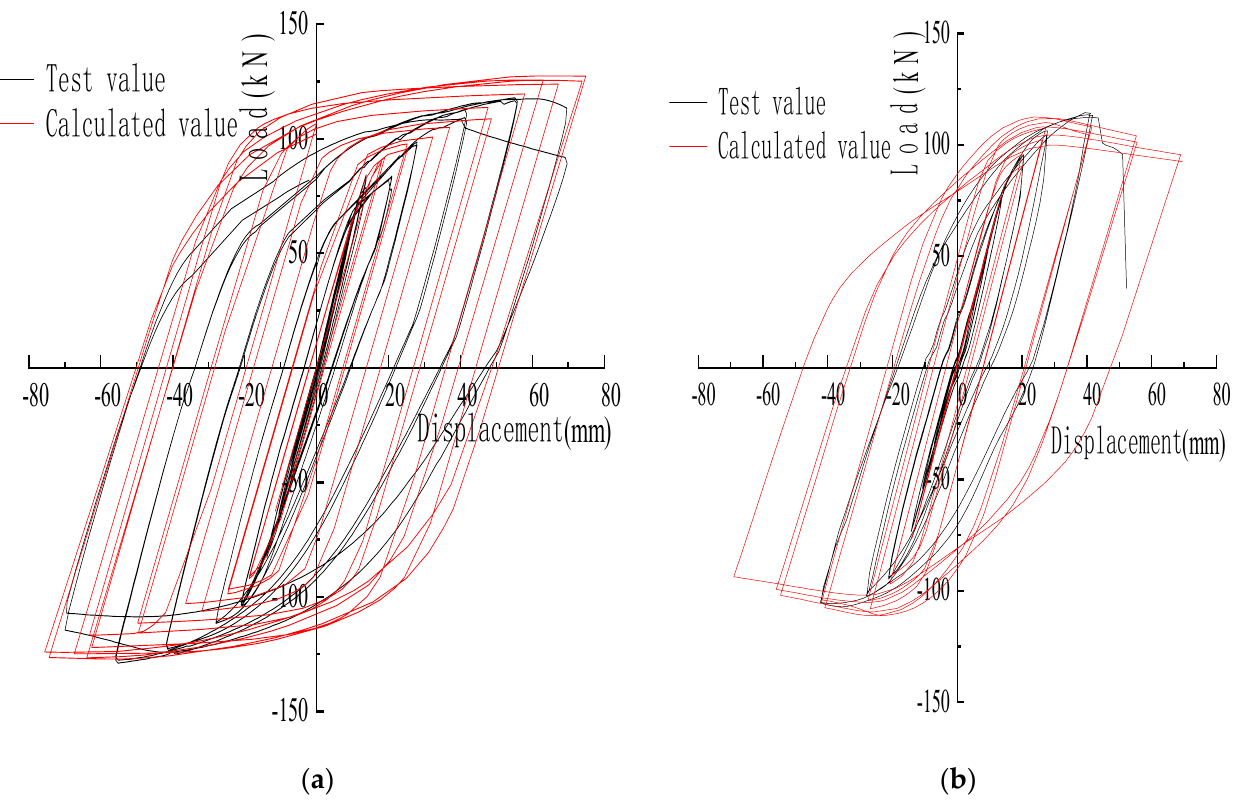
Figure 14. Comparison of hysteretic curves: ( a ) SRN; (b) NRN .